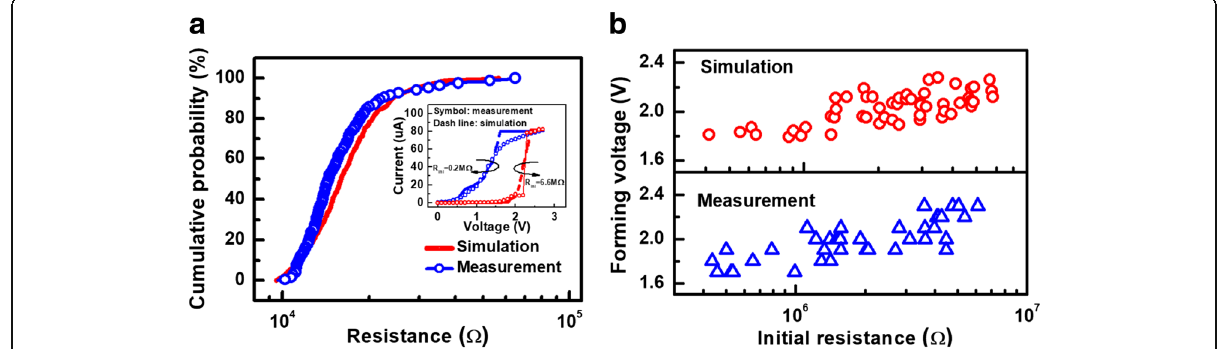
Fig. 9 a Simulated resistance distribution of forming operation agrees well with measurement result. b Positive correlations between initial resistance and forming voltage are found in both measured and simulated data due to more weak points and higher electric field strength produced by preforming.